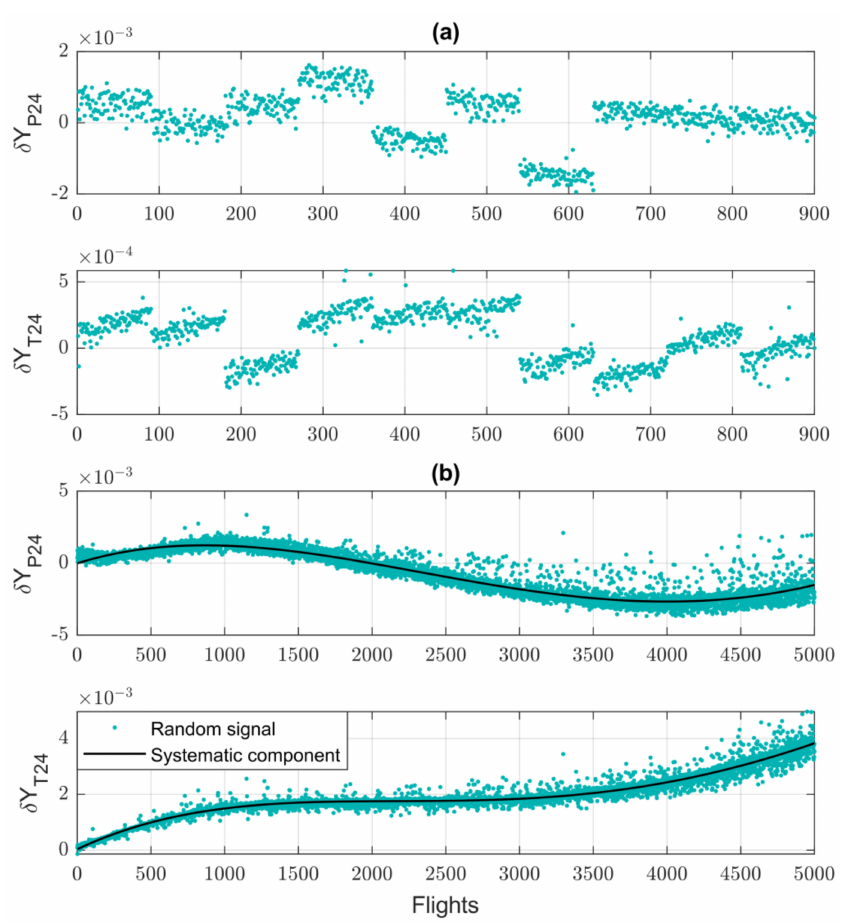
Figure 2. Deviations: ( a ) for a reference sample of 10 engines and their 90 first flights, ( b ) for baseline model verification with 1 engine through its service